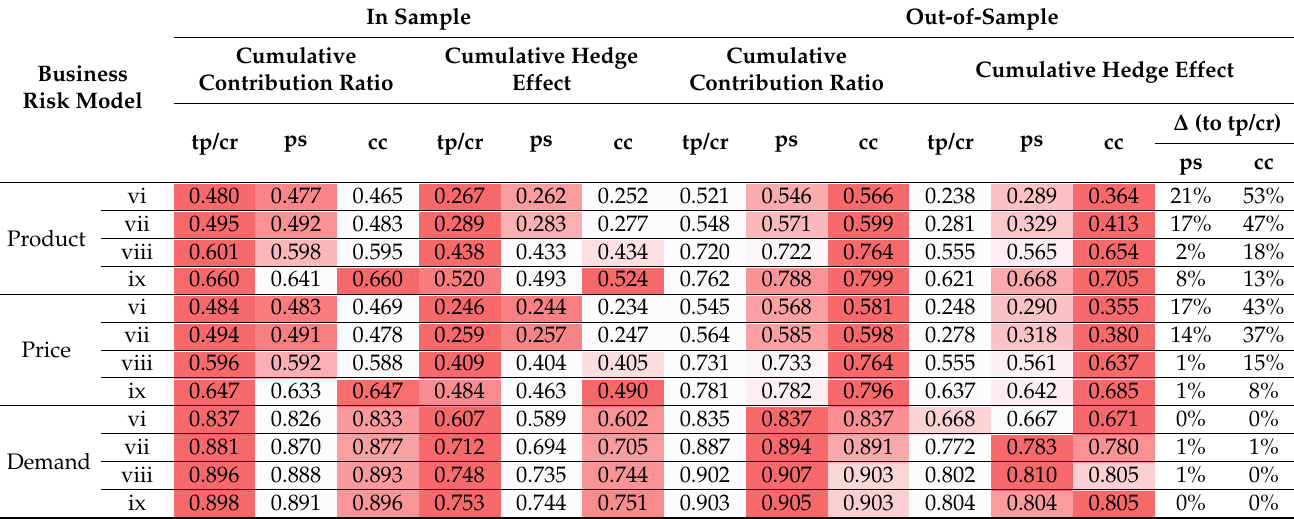
Figure 12. Monthly hedge effect for each business risk model. Table 1. Comparison of cumulative hedge effect/cumulative contribution ratio by